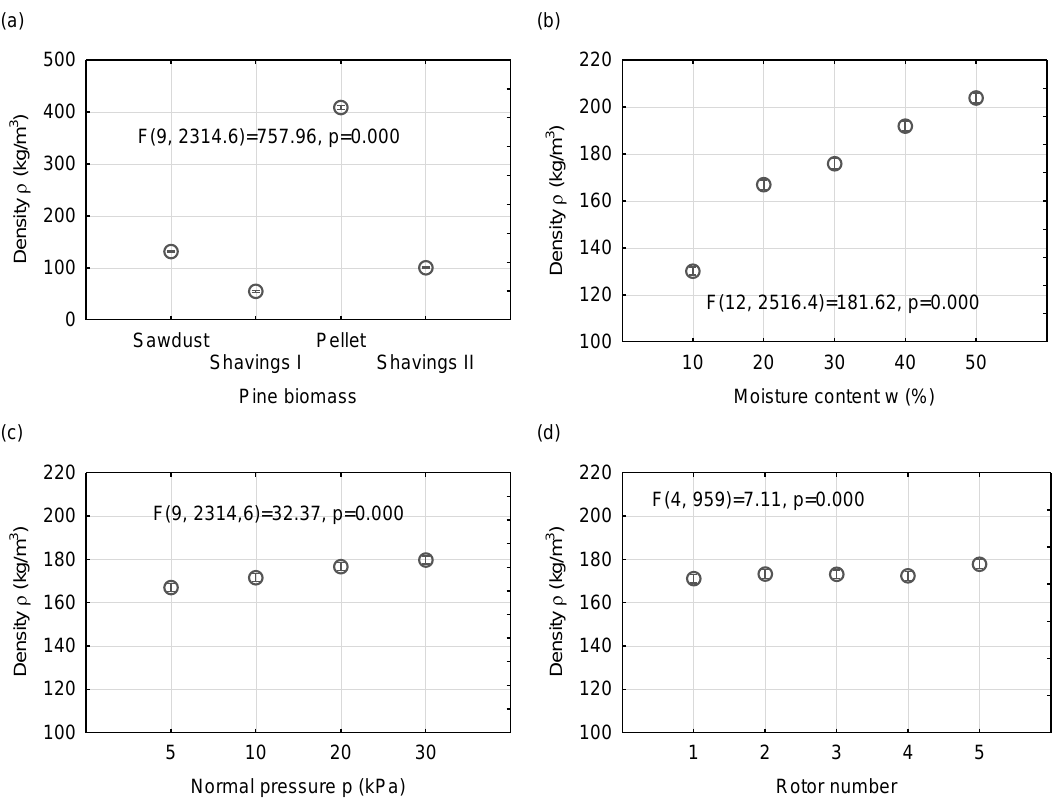
Figure 3. Mean value with 0.95 confidence intervals of bulk density calculated for the experimental materials ( a ) and mean bulk density influenced by the moisture content ( b ), normal pressure ( c ), and rotor number ( d ).